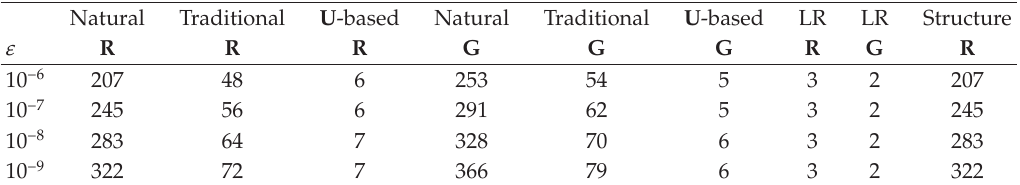
Table 3: Number of iterations required for di ff erent methods for interarrival times having probability